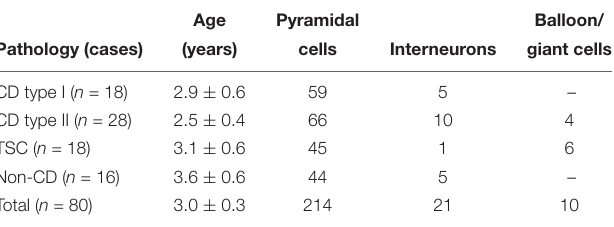
TABLE 1 | Pediatric epilepsy